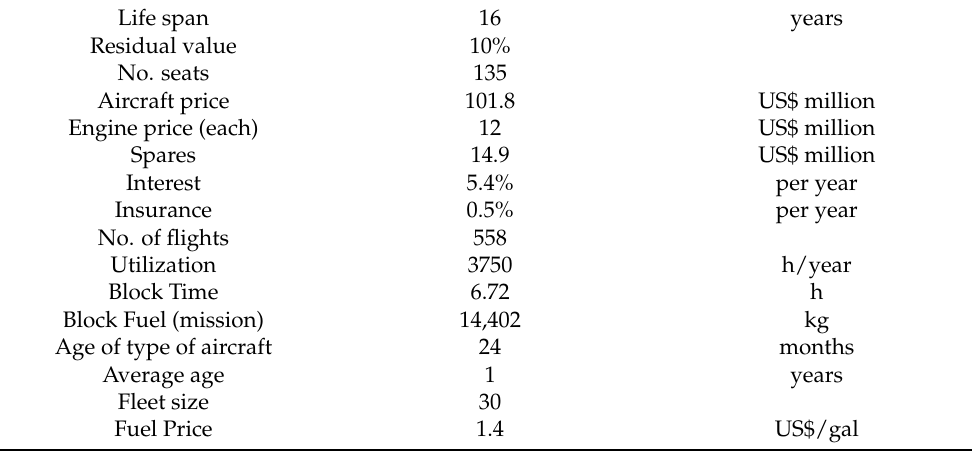
Table 14. Economic